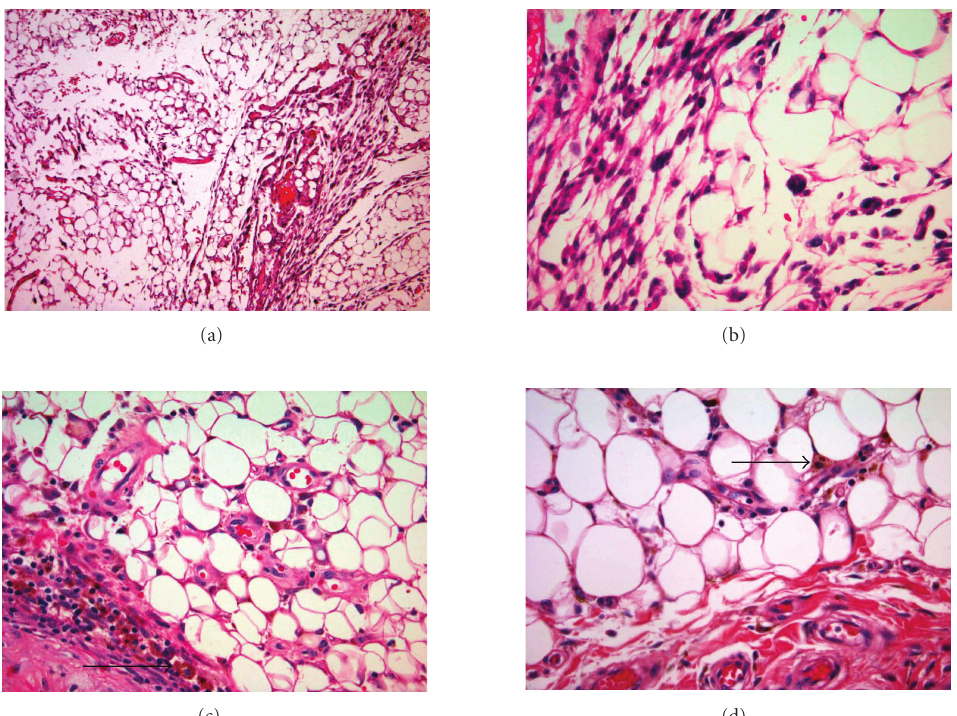
Figure 2: The upper left image shows the histology of HFLL. The upper right magnified image shows the spindled cell component of HFLL, whereas the inflammatory component of HFLL is shown in the lower left image, and macrophages with hemosiderin pigment (arrows) are shown in both the lower images. In all illustrations, mature adipocytes are